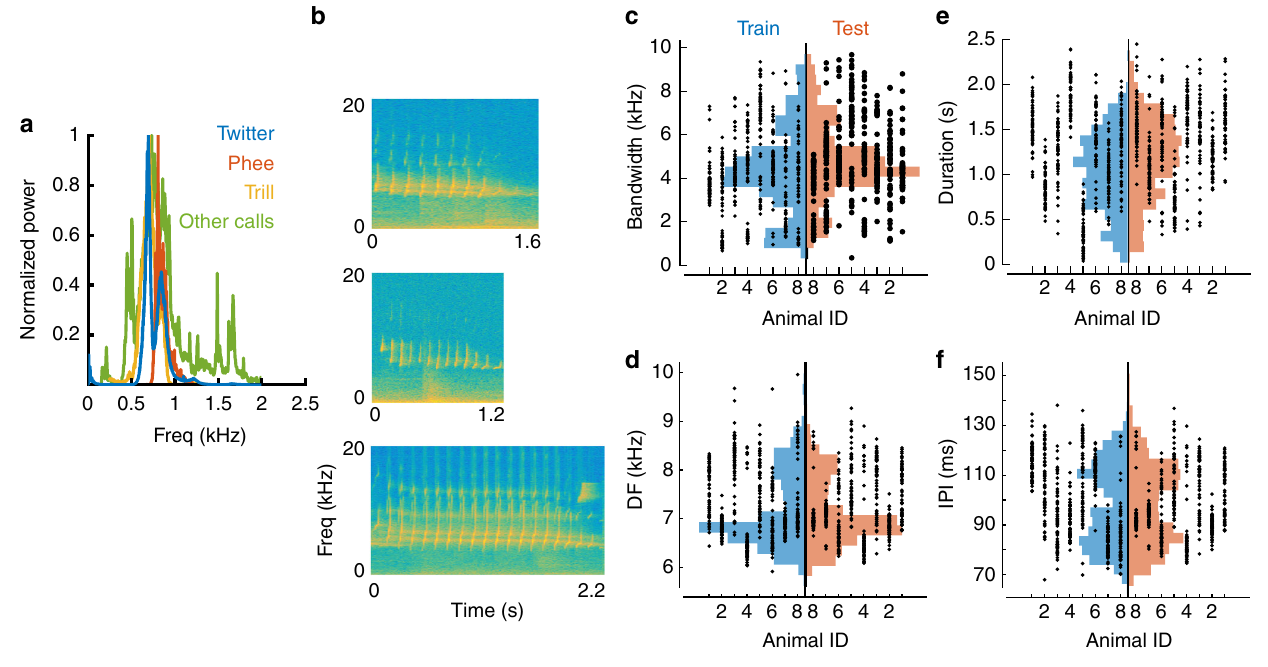
Fig. 1 Production variability in marmoset calls. a The overall spectra of 3 major marmoset call types and other minor call types (grouped as ‘ Other calls ’ ), showing spectral overlap between call categories. b Spectrograms of three twitter calls showing examples of production variability between individuals. c – f Production variability of twitter calls quanti fi ed along multiple parameters: c bandwidth, d dominant frequency, e duration, and f inter-phrase interval. Dots are parameter values of a single call produced by an individual marmoset. Histograms are overall parameter distributions, split into the training (blue) and testing (red) sets. These data show the large production variability captured by the training and test datasets, over which the model must generalize.